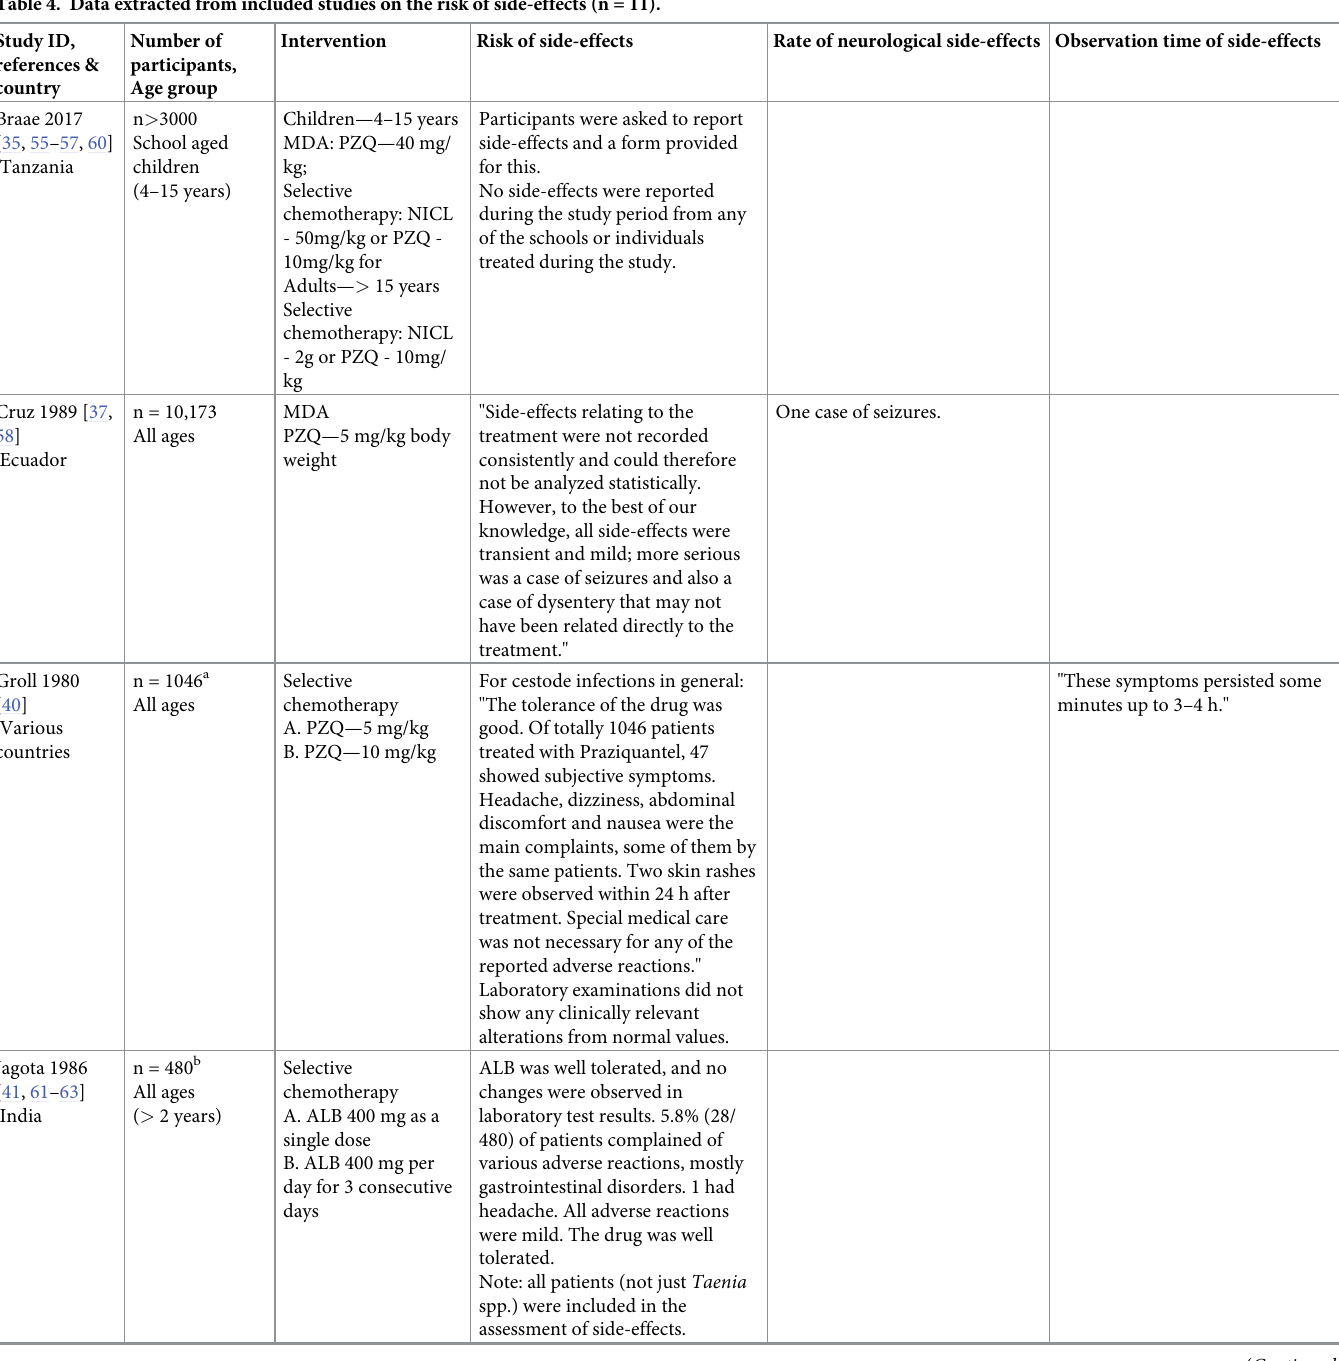
Table 4. Data extracted from included studies on the risk of side-effects (n =